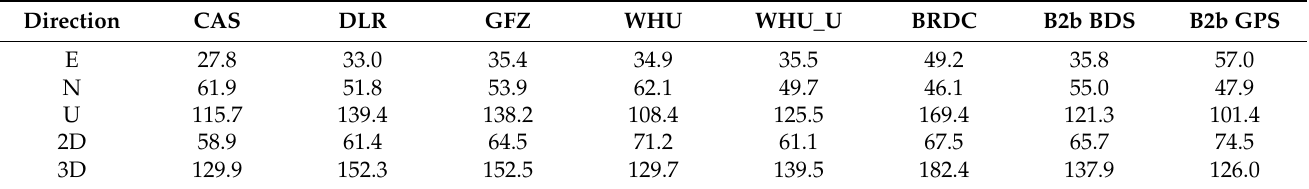
Table 8. Position RMSE of vehicle-borne real-time dual-frequency PPP using different SSR products (unit: cm).